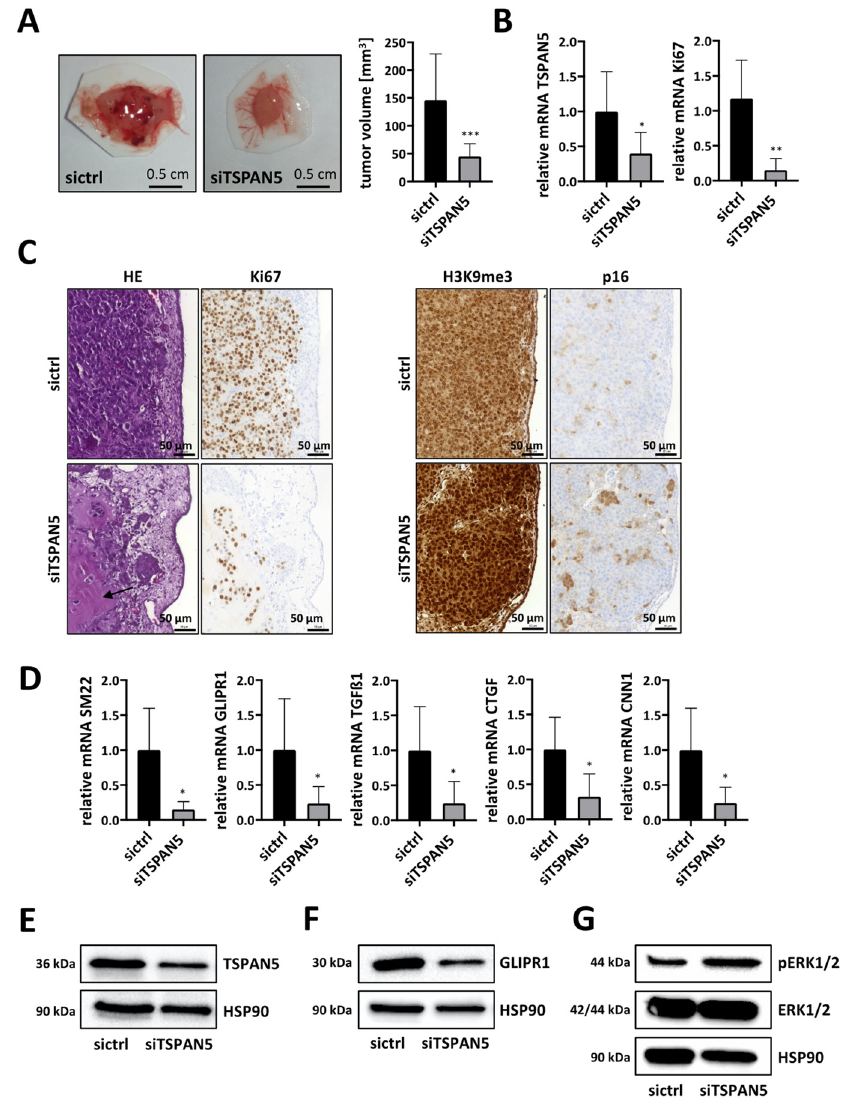
Figure 6. Anti-tumor effects of TSPAN5 depletion in the CAM assay. ( A ) HuH7 cells transfected with negative control siRNA (sictrl) and TSPAN5 siRNA (siTSPAN5) in Matrigel ® pellets were transferred to the CAM of fertilized chicken eggs. Five days later tumor pellets of HuH7 cells were extracted, ex ovo images of micro-tumors were taken and tumor volume was calculated. Data are presented as means ± SD ( n = 17); ***, p < 0.001. ( B ) Knockdown efficiency of TSPAN5 and Ki67 expression in micro-tumors generated in ( A ), determined by qRT-PCR using TSPAN5, Ki67 and 18S primers as endogenous housekeeping genes for normalization. Values are means ± SD ( n = 6); *, p < 0.05 and **, p < 0.01. ( C ) Left panel: representative photomicrographs of hematoxylin–eosin (HE)- and Ki67-stained paraffin sections of HuH7 sictrl and siTSPAN5 CAM tumors generated as in ( A ). Arrowhead: Undigested Matrigel. Scale bar = 50 µm. Right panel: Representative images of H3K9me3- and p16-stained paraffin sections of HepG2 sictrl and siTSPAN5 CAM tumors prepared as in ( A ). Scale bar = 50 µm. ( D ) RNA was purified from extracted micro-tumors developed from Matrigel and HuH7 cells treated with scrambled RNA (sictrl) or TSPAN5 siRNA (siTSPAN5) in ovo for 5 days and MRTF target gene expression analyzed by qRT-PCR as described in ( B ). Values are means ± SD ( n = 6); *, p < 0.05. ( E – G ) Lysates from extracted micro-tumors grown from HuH7 sictrl and HuH7 siTSPAN5 cells in ovo for 5 days as in ( A ) were immunoblotted with anti-TSPAN5 ( E ), anti-GLIPR1 ( F ), anti-ERK pT202/pY204 , anti-ERK ( G ) or anti-HSP90 antibodies as a loading control. The whole Wester Blots are available at Figure